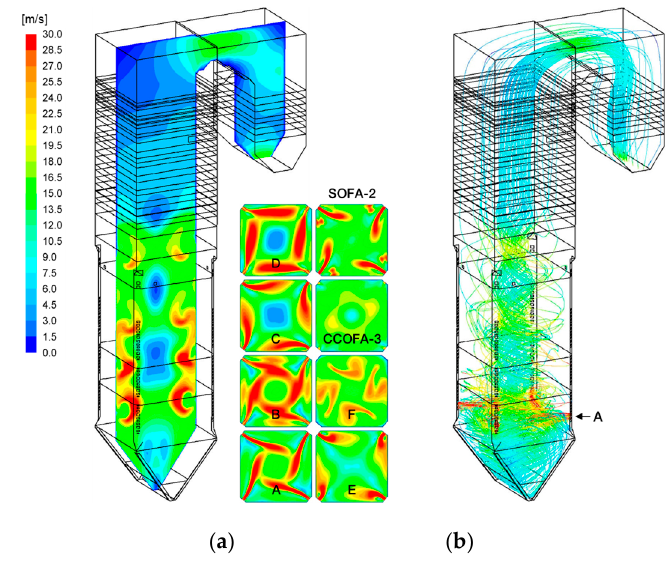
Figure 2. Velocity contours and path-line from burner A for the reference case (C05-S20) ( a ) Velocity and ( b ) Path-line.